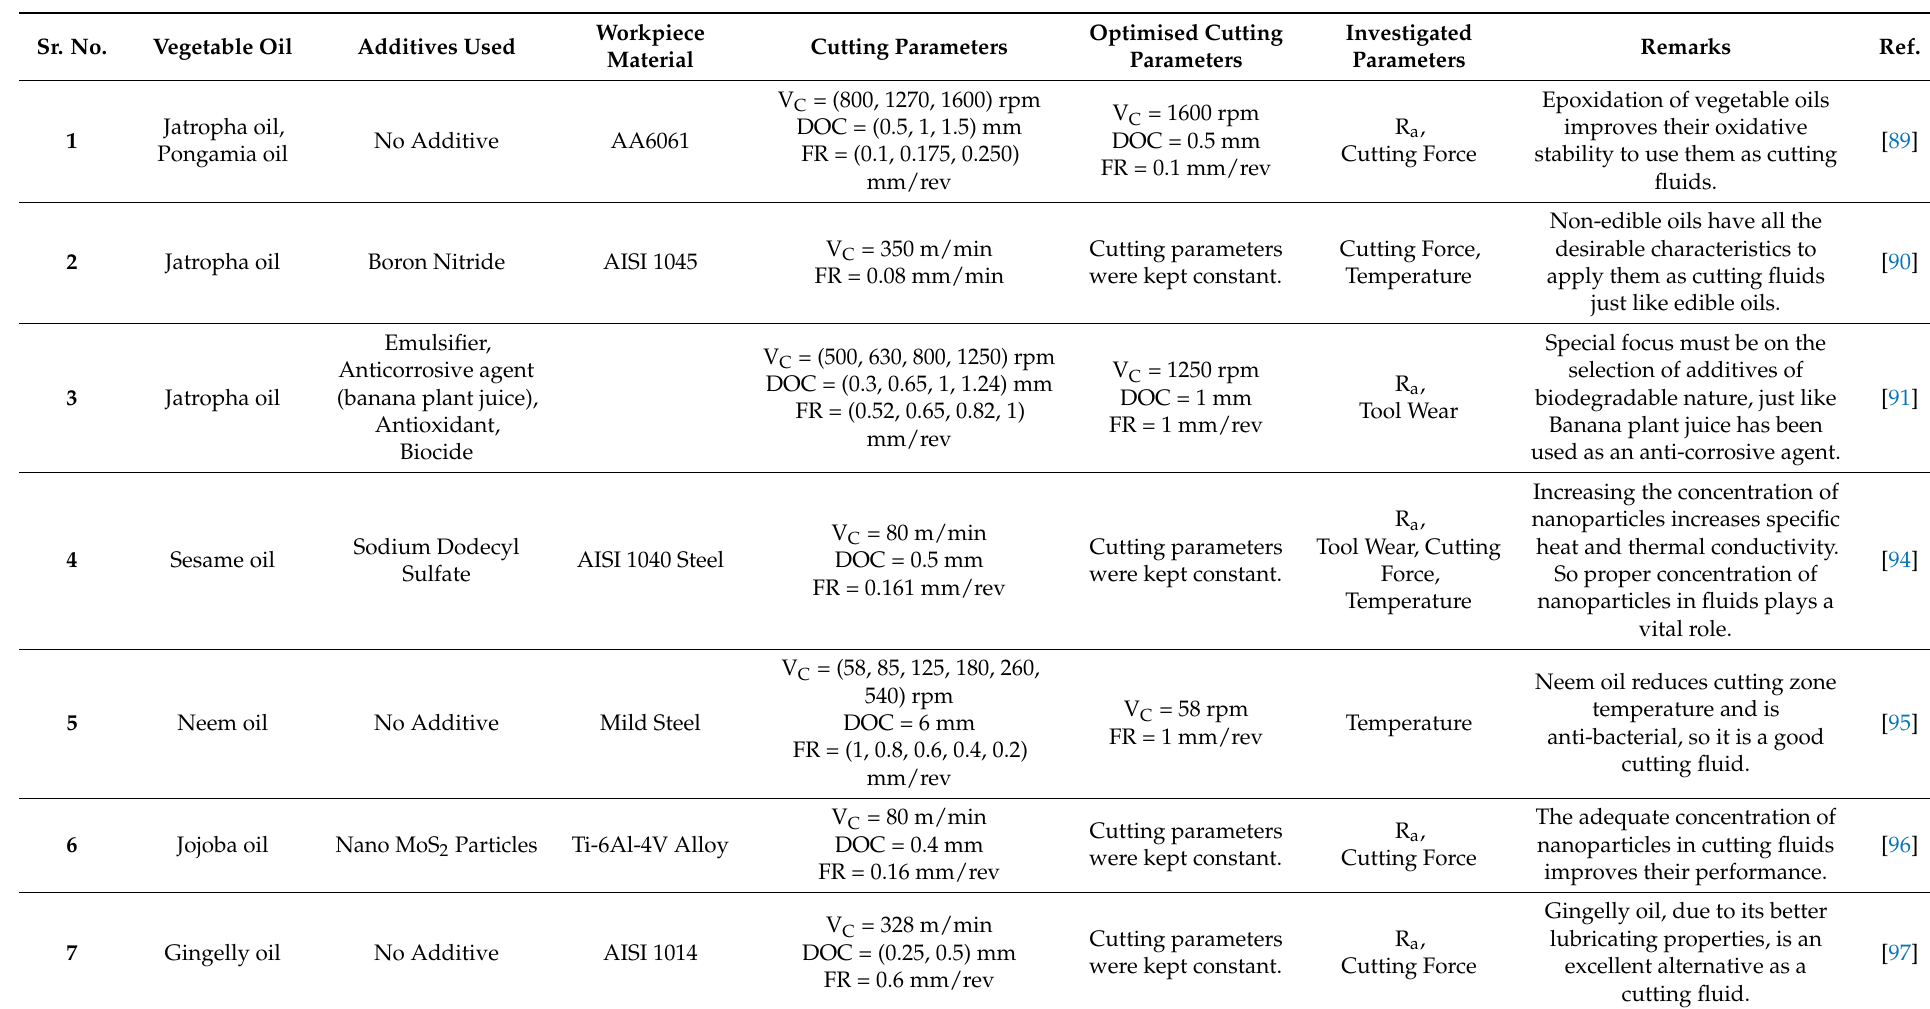
Table 2. Turning Operation Using Non-Edible Vegetable Oil-Based Cutting